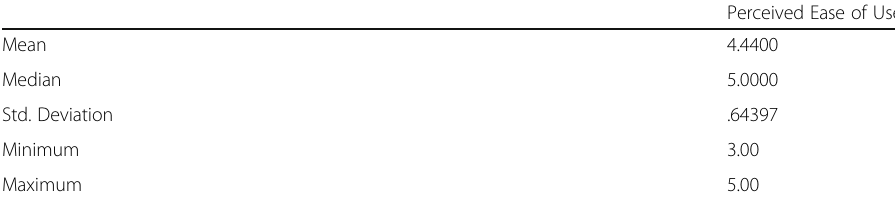
Perceived Ease of